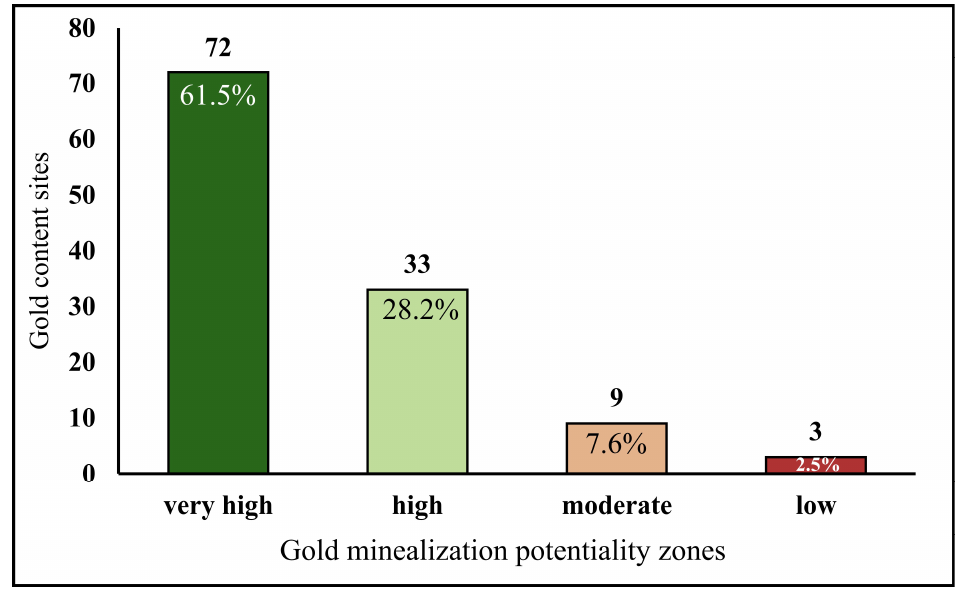
Table 7. The validation gird points to the gold mineralization potential zones map.